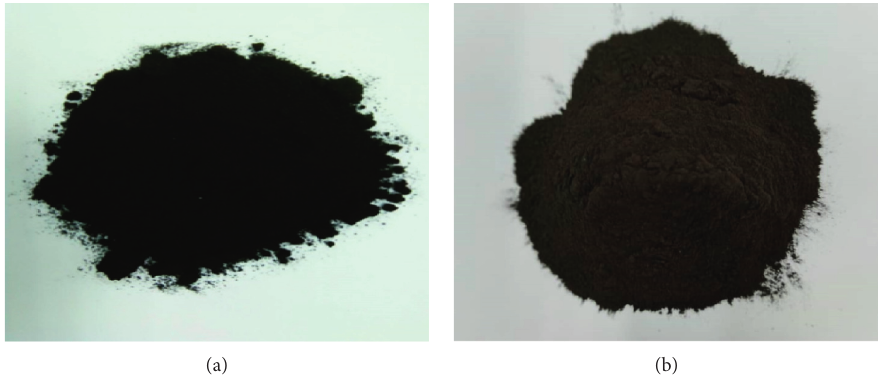
Figure 1: Physical appearance of industrial waste powders. (a) Crumb rubber powder. (b) Tin slag.